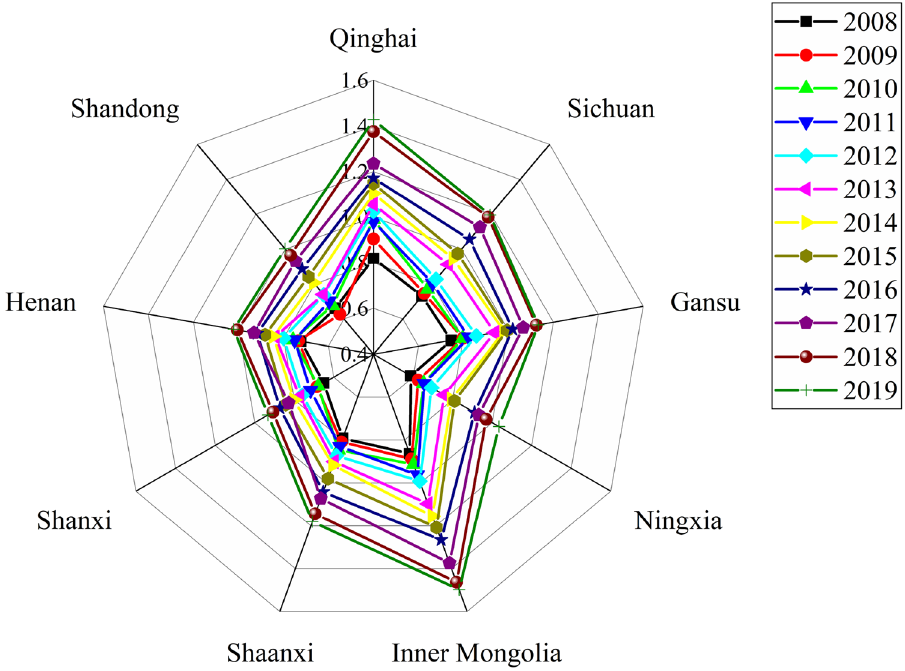
Figure 9. Radar map of provincial CCCEIs in the Yellow River basin from 2008 to